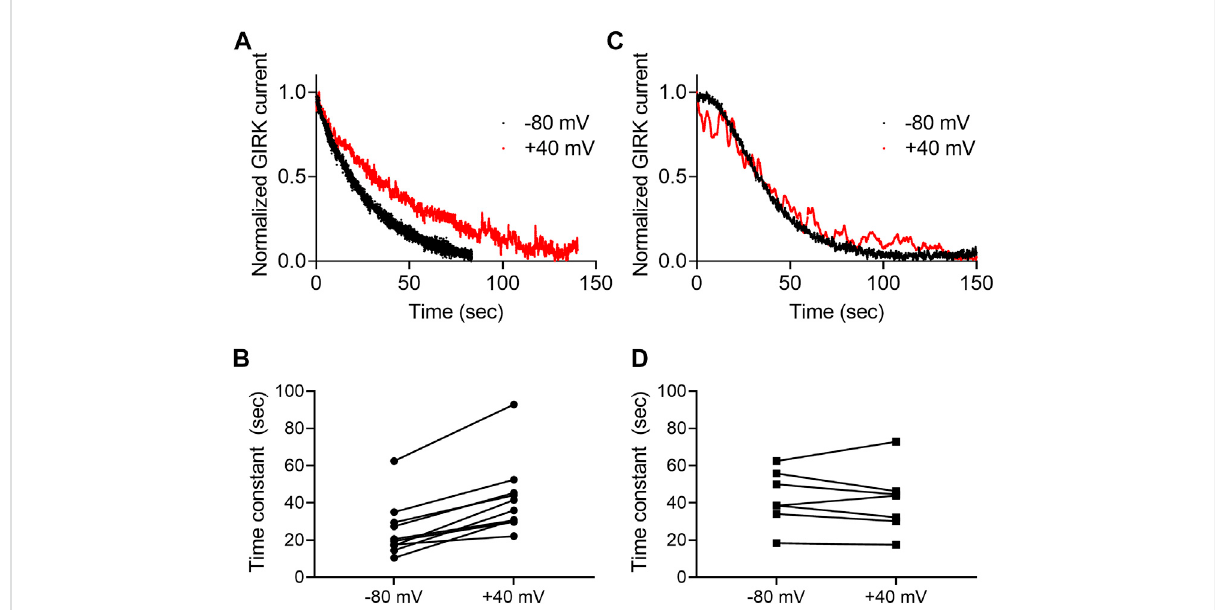
FIGURE 4 Voltage dependence of the dissociation of agonist from the CB1 receptor. (A) And (C) A comparison of the decay of GIRK currents at − 80 mV (black) or at +40 mV (red). The currents were evoked following activation with 2-AG (A) or AEA (C) . The washout of the agonists took place at time 0 and the currents were normalized to enable comparison between the two recordings. (B) and (D) . Time constants of decay measured of − 80 mV and +40 mV. The currents were evoked following activation with 2-AG (B) or AEA (D) .Each two data points connected with aline represent the same oocyte at the two holding